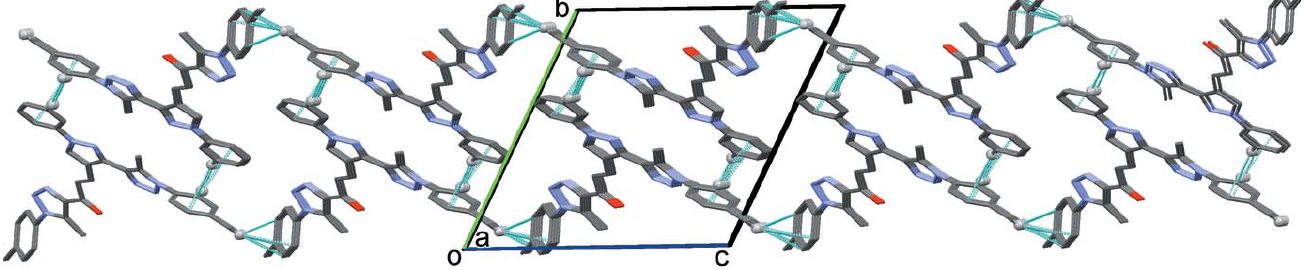
Figure 3 Aview along the a axis of the crystal packing of the title compound, with the C—H (cid:3)(cid:3)(cid:3) (cid:2) interactions (Table 1) represented by dashed lines. Only H atoms H1 A , H7 A and H18 A (grey balls) have been included.